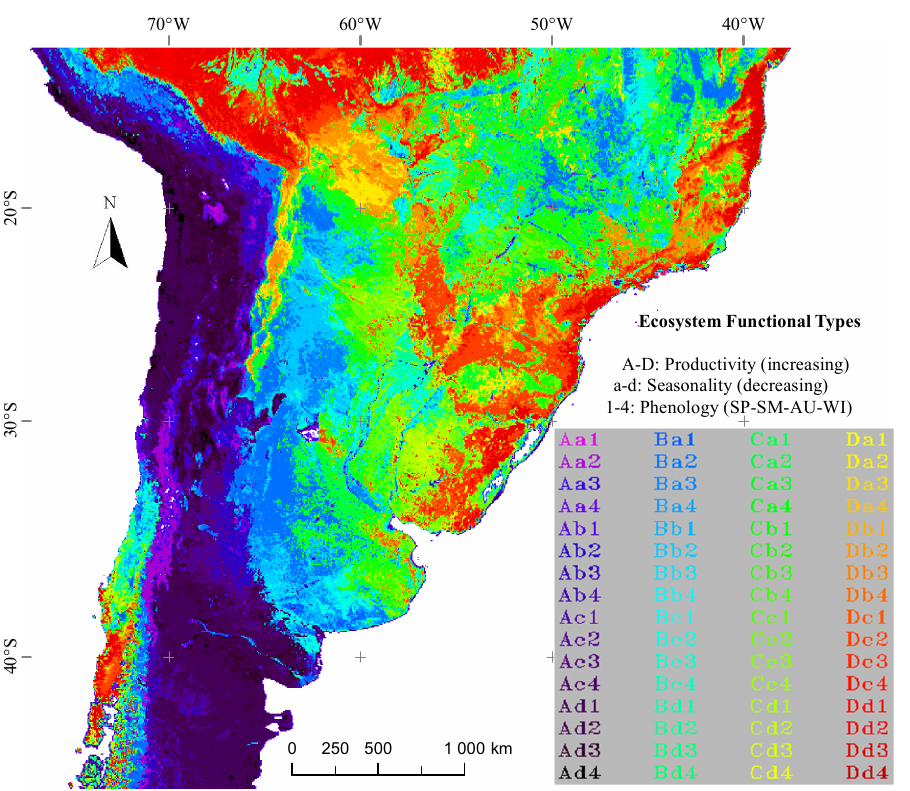
Figure 2. Ecosystem Functional Types (EFT) of temperate South America based on Moderate Resolution Imaging Spectroradiometer Enhanced Vegetation Index (MODIS-EVI) dynamics (0.05° pixel). The map shows the EFTs corresponding to the median of the 2001–2008 period. Capital letters correspond to the EVI annual mean (EVI_Mean) level, ranging from A to D for low to high productivity. Small letters show the seasonal coefficient of variation (EVI_sCV), ranging from a to d for high to low seasonality of carbon gains. The numbers indicate the season of maximum EVI (DMAX): ( 1 ) spring, ( 2 ) summer, ( 3 ) autumn, ( 4 ) winter. The map uses the 0.05º Global Climate Model Grid in geographic projection.